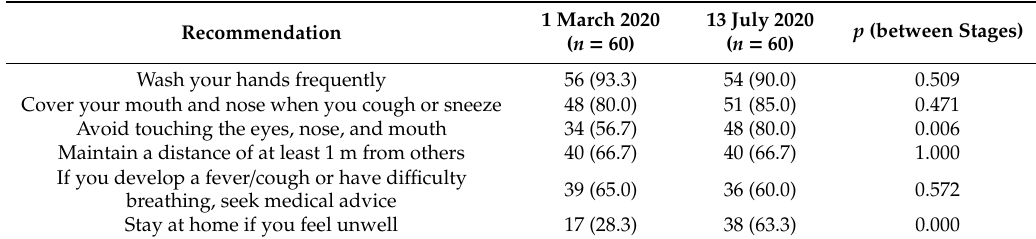
Table 2. Available recommendations of the WHO by the search date.